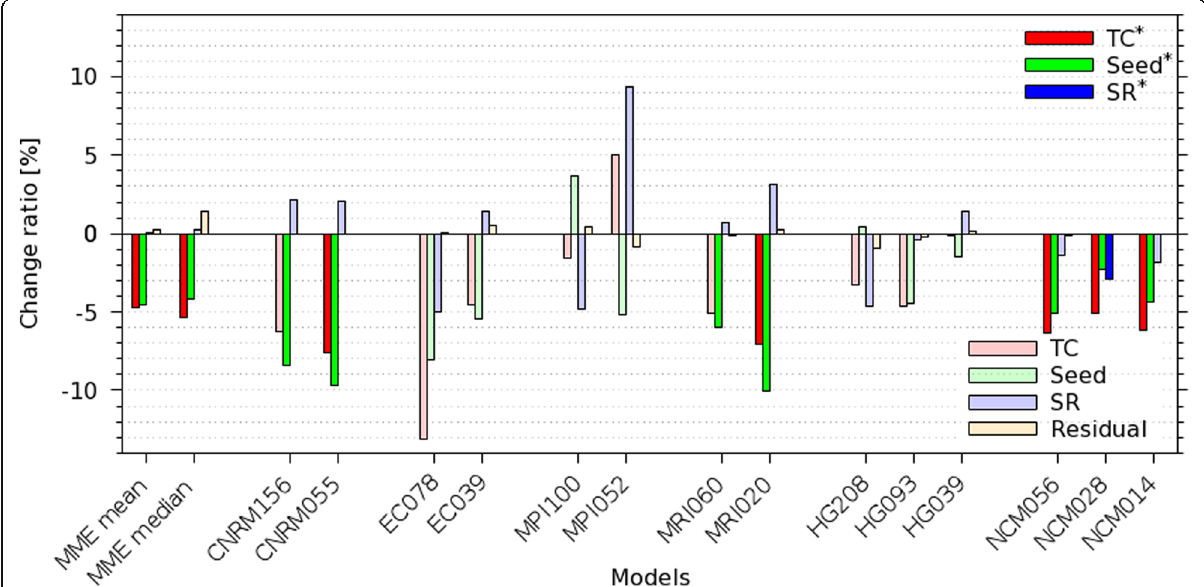
Fig. 6 Change ratio of TC genesis frequency, TC seed frequency, and survival rate. Horizontal axis indicates models. Change ratio was calculated based on the ratio of differences between mean values of the future climate (2025 – 2049) and the present-day climate (1990 – 2014) to the mean value of the present-day climate. In NCM014, we regard 2000 – 2009 as the present-day climate, and 2040 – 2049 as the future climate. Residual (Resi) was calculated based on Eq. 2. MME mean and median indicates change ratio of TC genesis frequency, TC seed frequency, and survival rate calculated from the multi models except NCM014, which were normalized based on the mean value from 1990 to 2014. Deep colored boxes indicate that its change is statistically significant at least 90% level with the Wilcoxon rank-sum